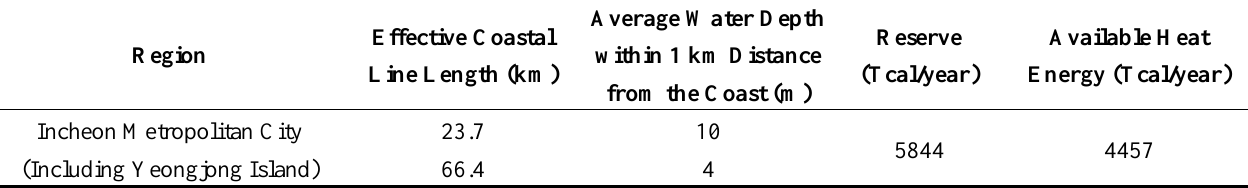
Table 4. Effective coastal line length and sea water heat energy reserve in Incheon region.